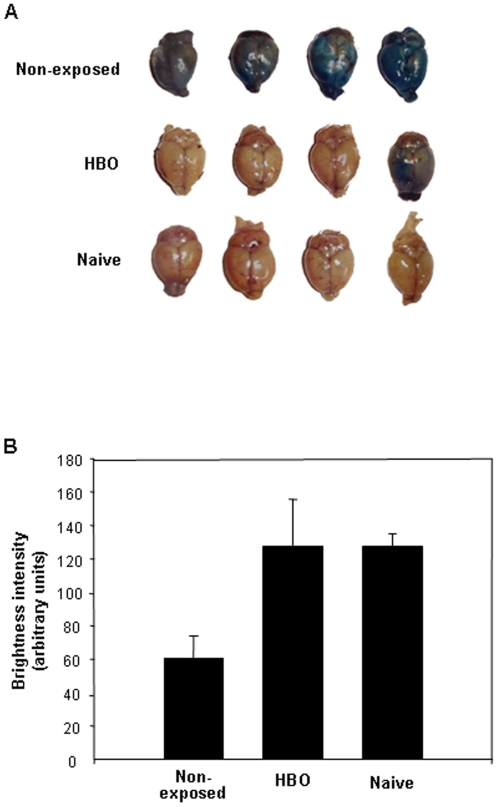
HBO preserves integrity of the blood-brain barrier in PbA-infected mice.Four PbA-infected mice, representative of each group (n = 8) exposed or not to HBO treatment (100% O2, 3.0 ATA, 1 hour per day), received i.v. injections of 1% Evans Blue solution early on day 7 p.i.. (A) One hour after Evans Blue injection, brains of naïve animals, PbA-infected mice and HBO-treated PbA-infected mice were collected and photographed (n = 4 of each group). (B) The BBB dysfunction of naïve mice or PbA-infected animals, regardless of submission to hyperbaric conditions, was determined by brain staining quantification with the aid of the ImageJ™ software (n = 4 of each group). HBO significantly reduced (P<0.005) the staining in the brains of infected-mice in comparison to non-treated animals. No statistical difference (P>0.05) was noticed between naïve and HBO-treated infected mice and brains collected from non-treated infected mice were significantly (P<0.005) darker than naïve animals. Results are expressed as the mean of brightness intensity of each delimited brain area of six mice±standard deviation.